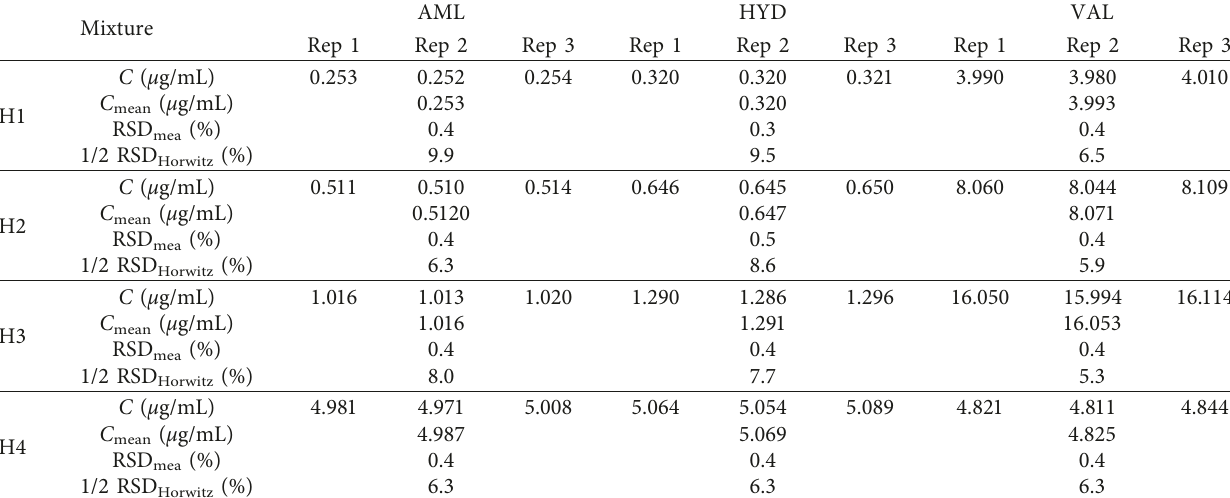
Table 6: Method repeatability.